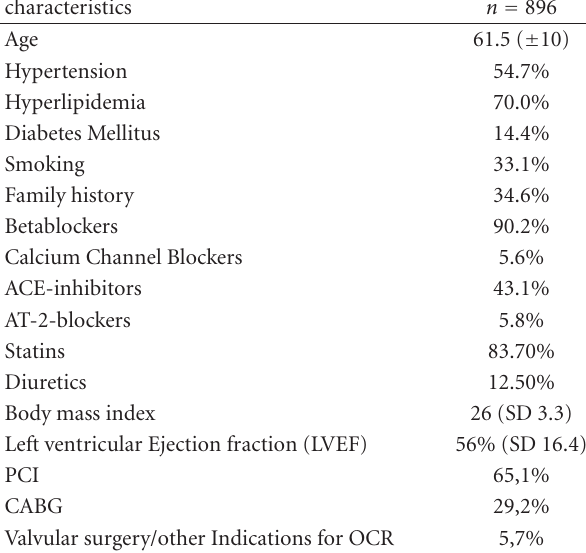
Table 1: Patient characteristics at baseline.